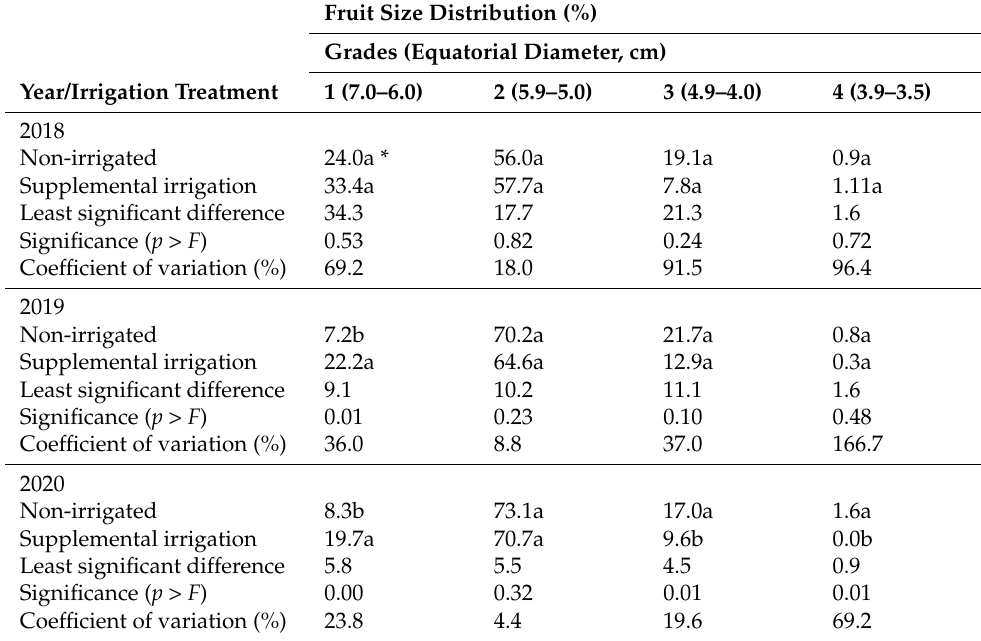
Table 3. Influence of supplemental irrigation on the fruit size distribution of ‘Roja Lisa’ cactus pear. Fruit were harvested from the commercial orchard ‘Las 100 Hect á reas’. La Victoria, Pinos, Zacatecas,